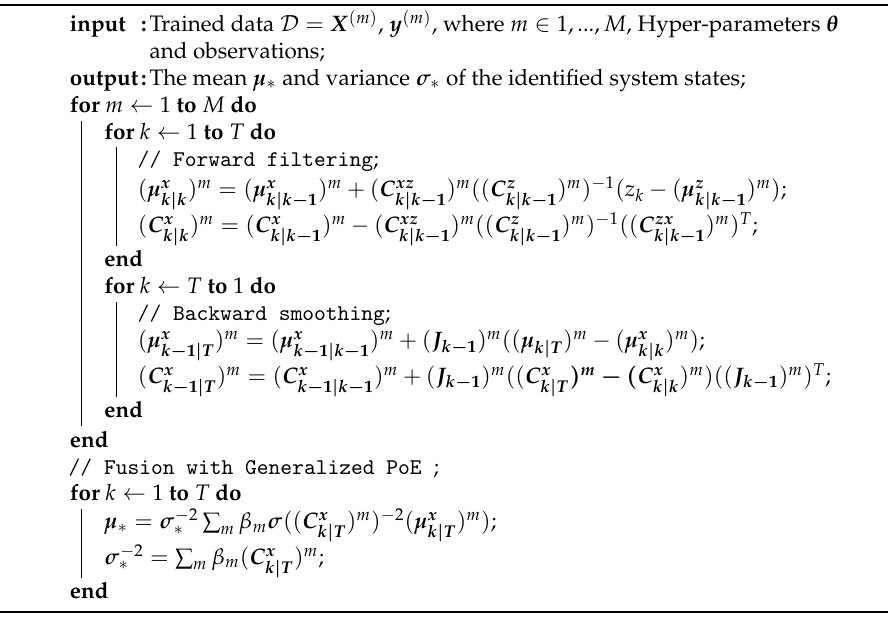
Figure 5. Computation time, RSME and NLL for the different number of GP experts. The computation time is measured in MATLAB 2015b (MathWorks Company, USA) on a laptop ( 2.6 GHz cores and 8 GB RAM) with a Ubuntu 16.04 system (Canonical Ltd., UK). Each case of different numbers of GP experts is tested 20 times for the purpose of reducing the stochastic data influence. Algorithm 2: Inference with Monte Carlo Markov